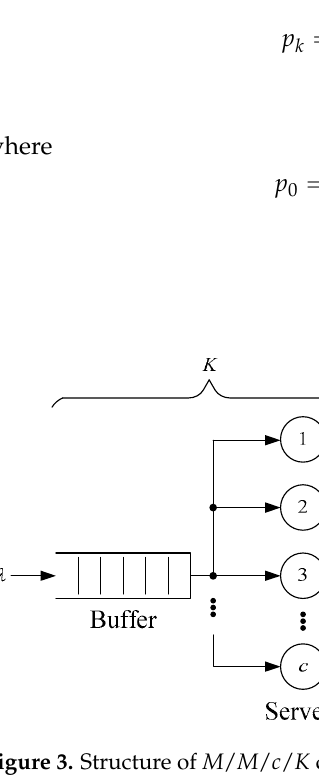
Figure 3. Structure of M / M / c / K